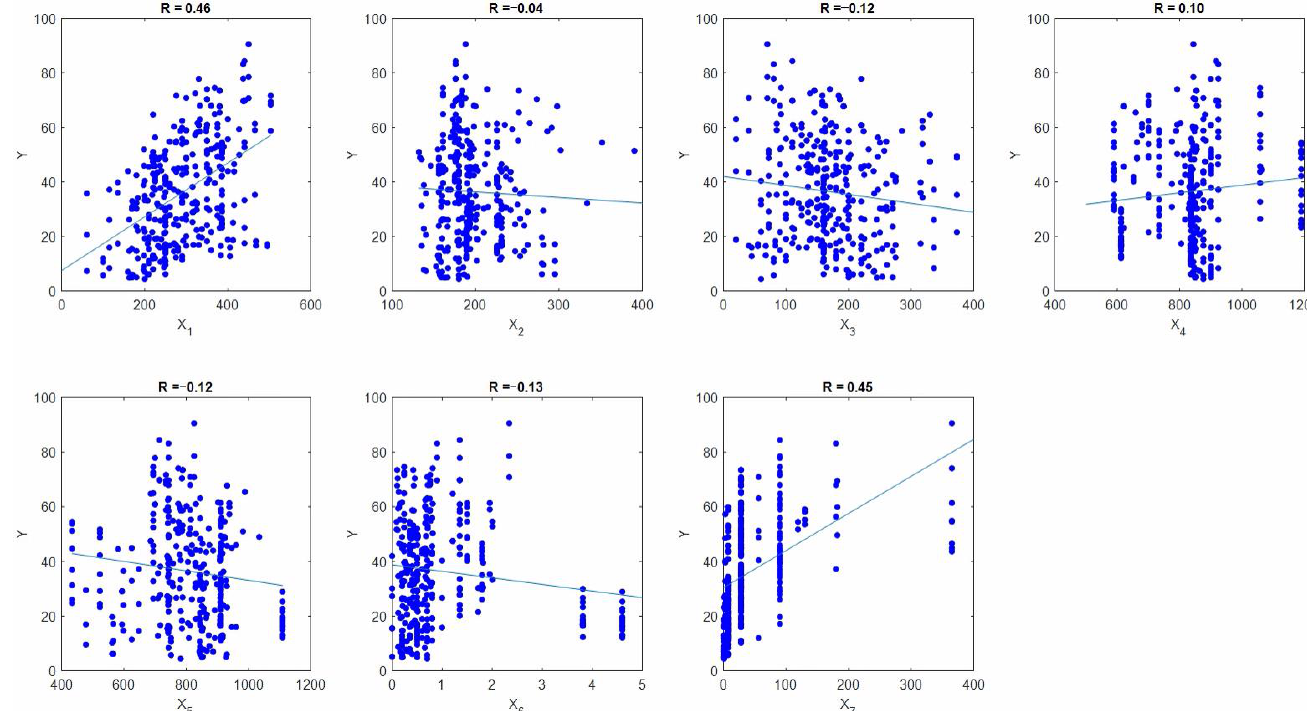
Figure 2. Scatter plots of variables in Dataset 2.